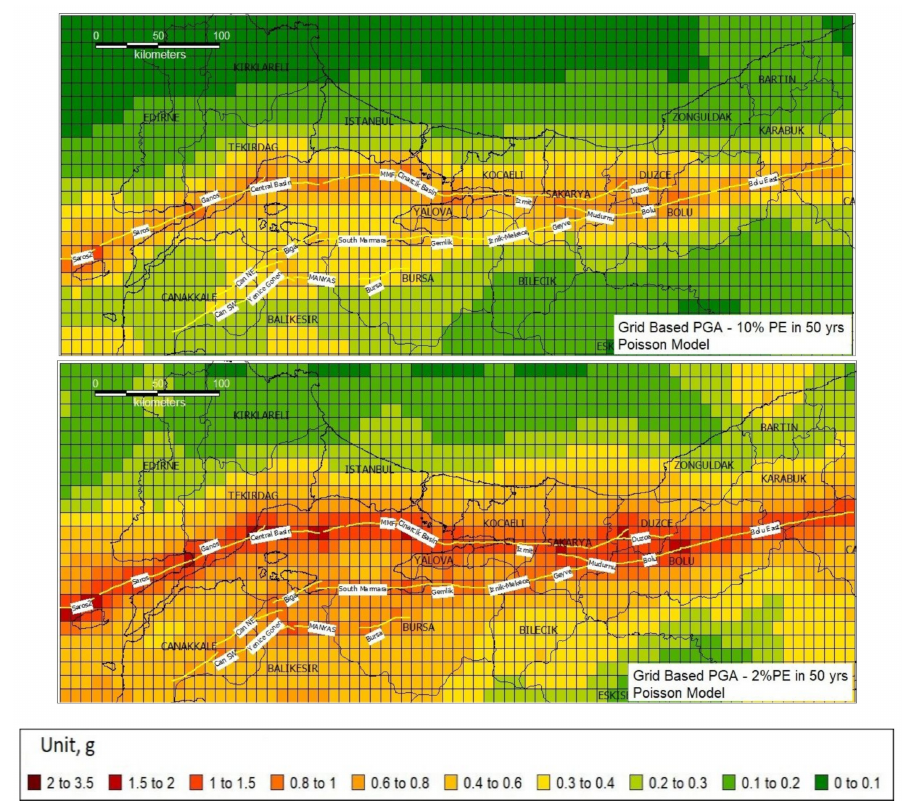
Figure 17. Grid-based PGA distribution at NEHRP B / C boundary site class for 10% (upper panel) and 2% (lower panel) probabilities of exceedance in 50 years (Poisson